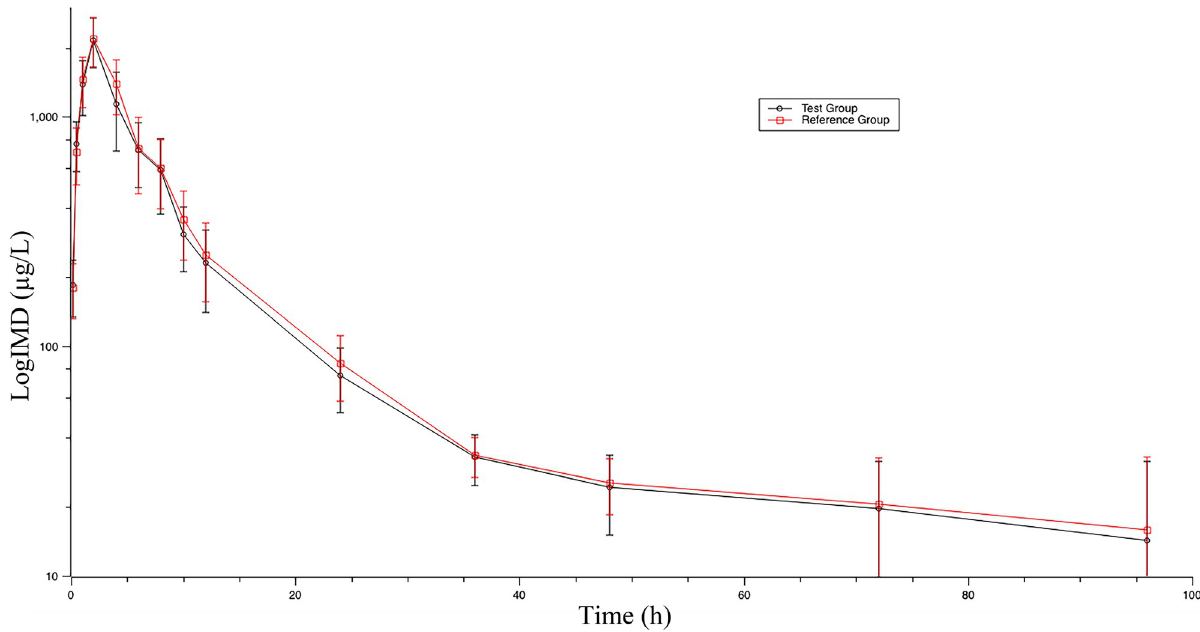
Fig 4. Plasma concentrations (mean+SD) of IMD in cattle following a single subcutaneous injection of 3.0 mg/kg. Error bars represent standard deviations.